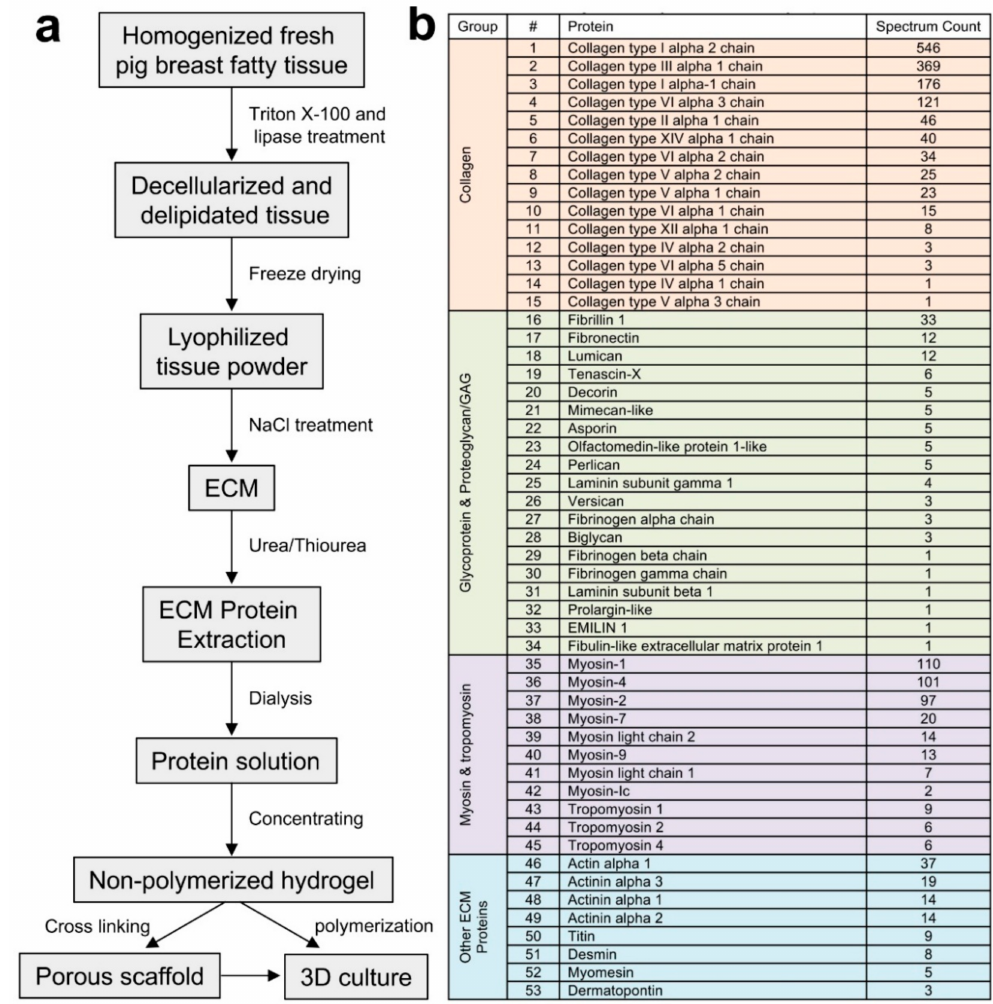
Figure 1. Extracellular matrix (ECM) protein extraction and identification from porcine breast fatty tissues. ( a ) Outline of the major steps of the breast ECM protein extraction and downstream applications. ( b ) The major ECM proteins of porcine breast fatty